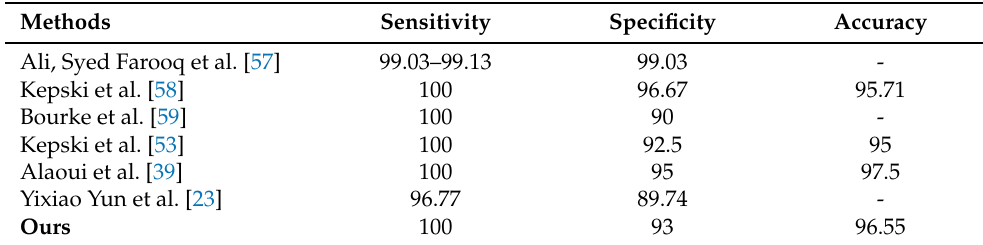
Table 4. URFD dataset: Sensitivity, specificity and accuracy of our work in comparison to state-of- the-art methods.